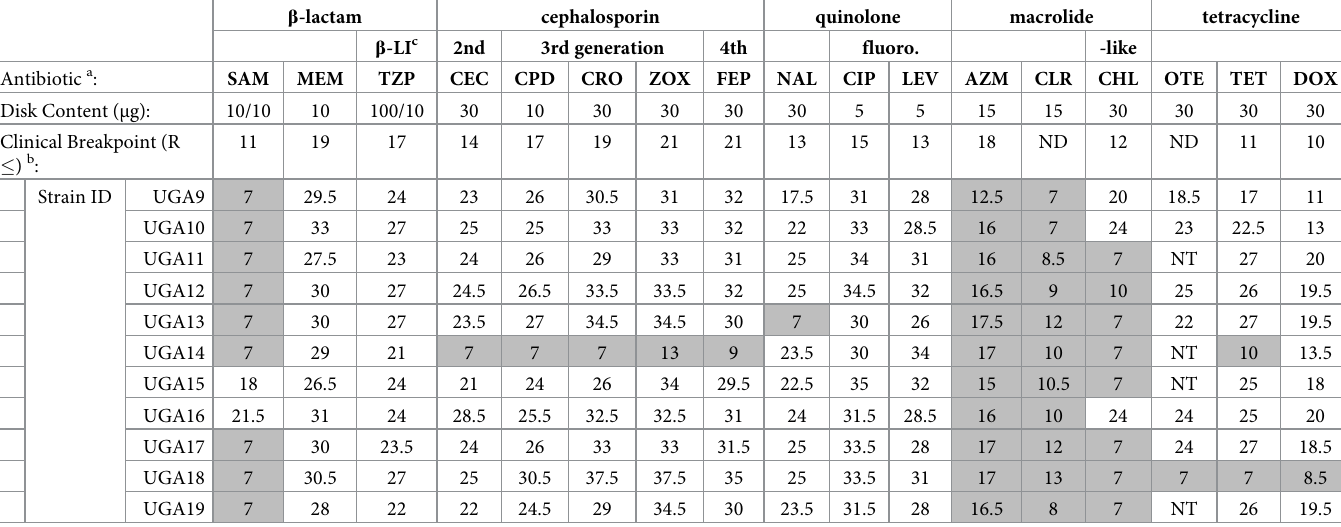
Table 1. Antimicrobial susceptibility testing of Salmonella UGA isolates by disk